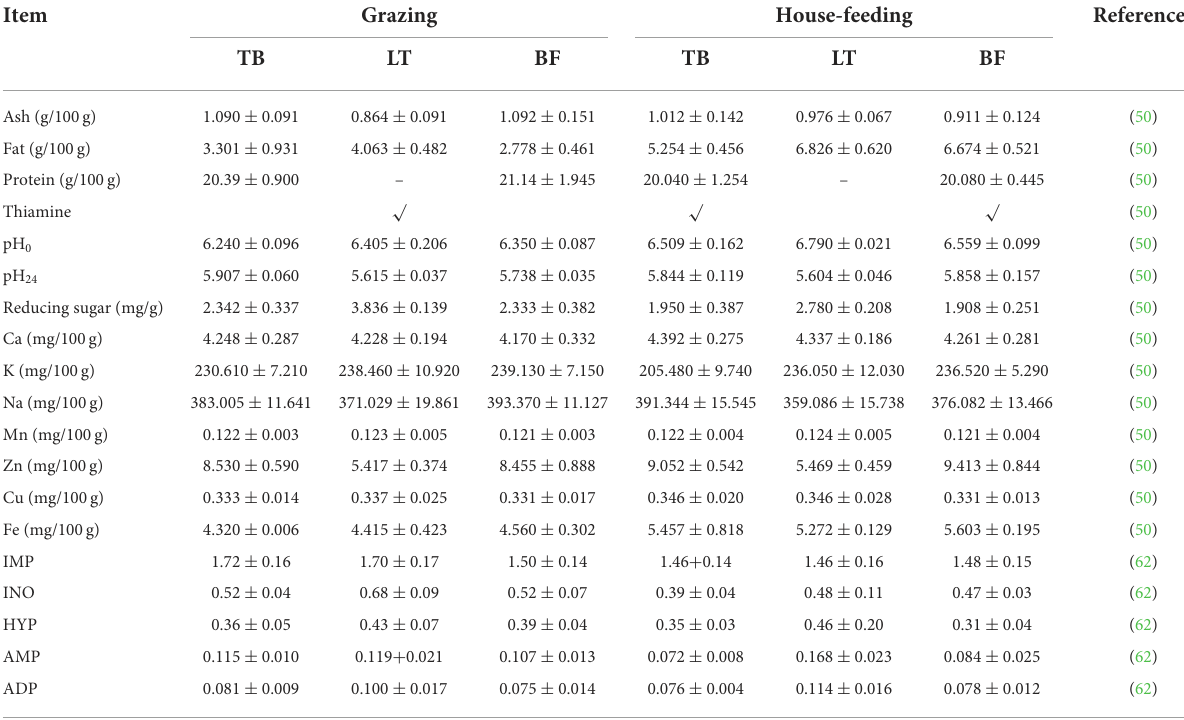
TABLE 2 Effects of feeding regimes on meat quality, nutrients, trace elements and umami substances of Triceps brachii (TB), Longissimus thoracis (LT), Biceps femoris (BF) of Sunite sheep.